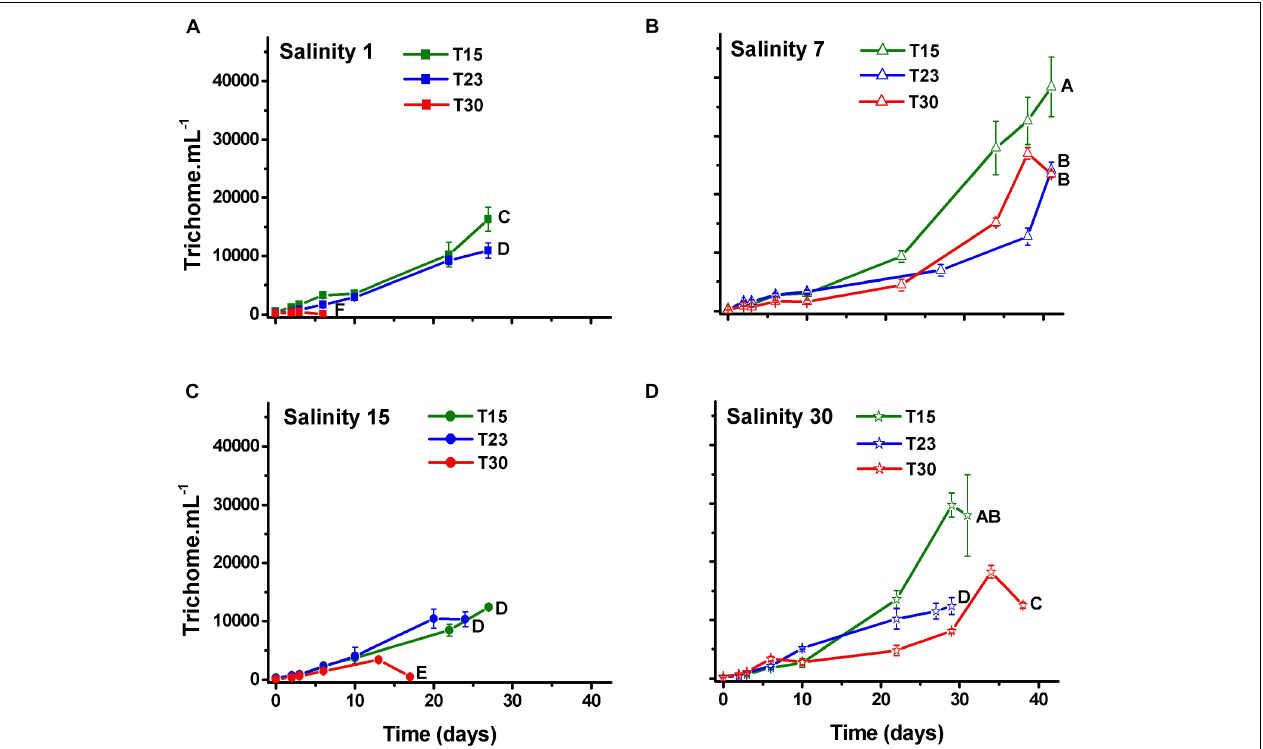
FIGURE 3 | Trichome density ( ± SD; n = 3) of N. spumigena (NODSPU1) observed along the time in the factorial experiment, which analyzed the influence of temperature (T15, T23, T30 ◦ C) and salinity S1 (A) , S7 (B) , S15 (C) , and S30 (D) . Significant difference between treatments is indicated by letters (ANOVA, Tukey’s p <